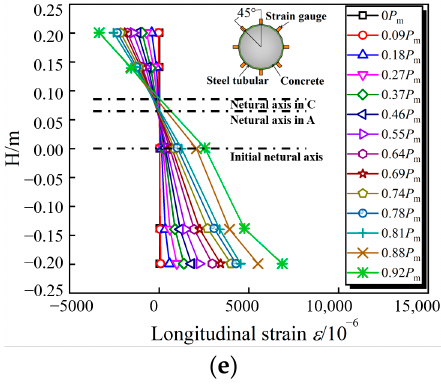
Figure 9. Longitudinal strain distribution at mid-span. ( a ) C240; ( b ) C280; ( c ) C320; ( d ) C360; ( e ) C400.